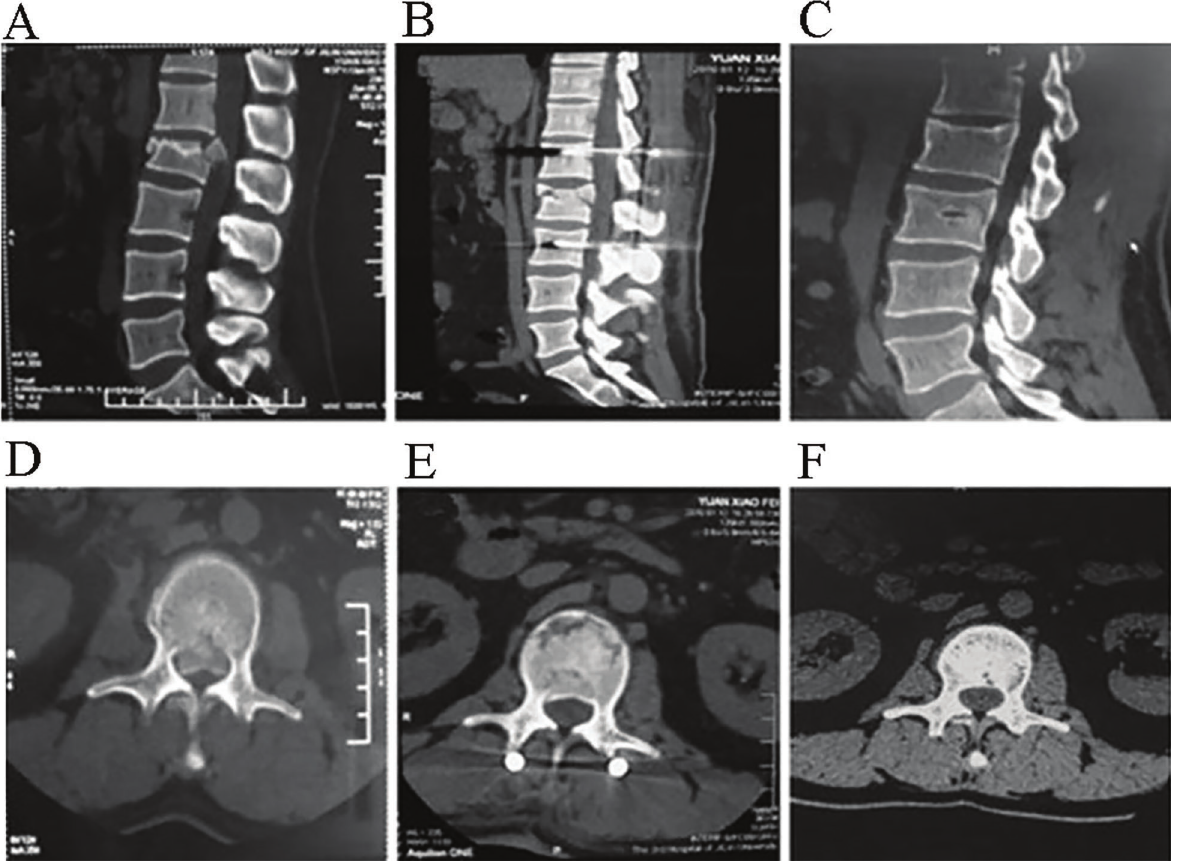
Figure 1. CT images showing signi fi cant restoration of the posterior and anterior vertebral height after surgery ( B ) and 2 years postoperatively ( C ), compared with the preoperative image ( A ). Postoperative axial CT image ( E ) showing signi fi cant canal decompression compared with the preoperative image ( D ). F , postoperative image two years after surgery showing that the canal was still